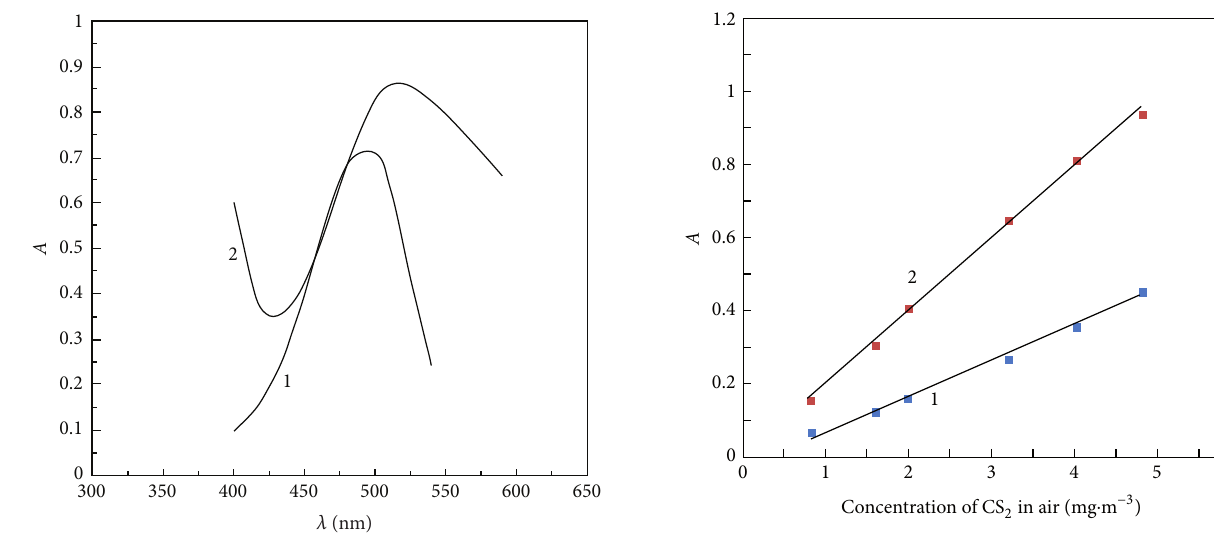
F 3: Simple absorption spectra; 1: DTNB method, 2: BTC method.